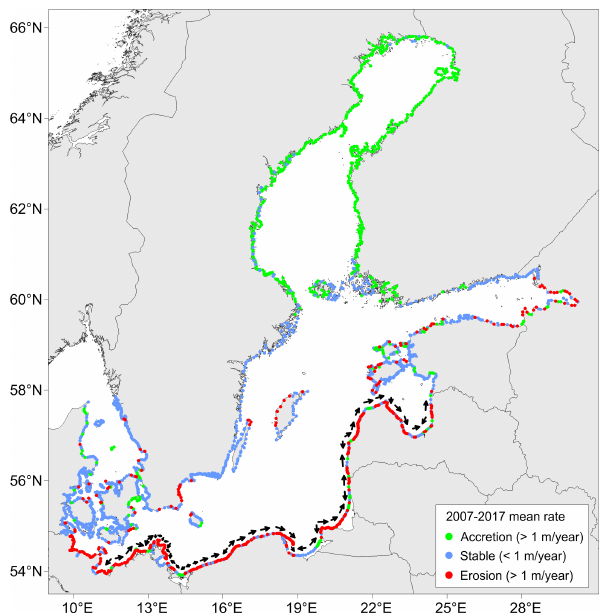
Figure 8. Rate of mean annual coastline change from 2007 to 2017 in the Baltic Sea based on a combination of satellite data for sandy beaches (Luijendijk et al., 2018) and field measurements for other coastline types (https://www.emodnet-geology.eu/, last ac- cess: 13 August 2021). Note that the accretion of the northern Baltic Sea coast is due to land uplift instead of sedimentation. The primary alongshore sediment transport direction along the sandy southern Baltic Sea coast is indicated by the arrows based on existing litera- ture compiled by Harff et al.